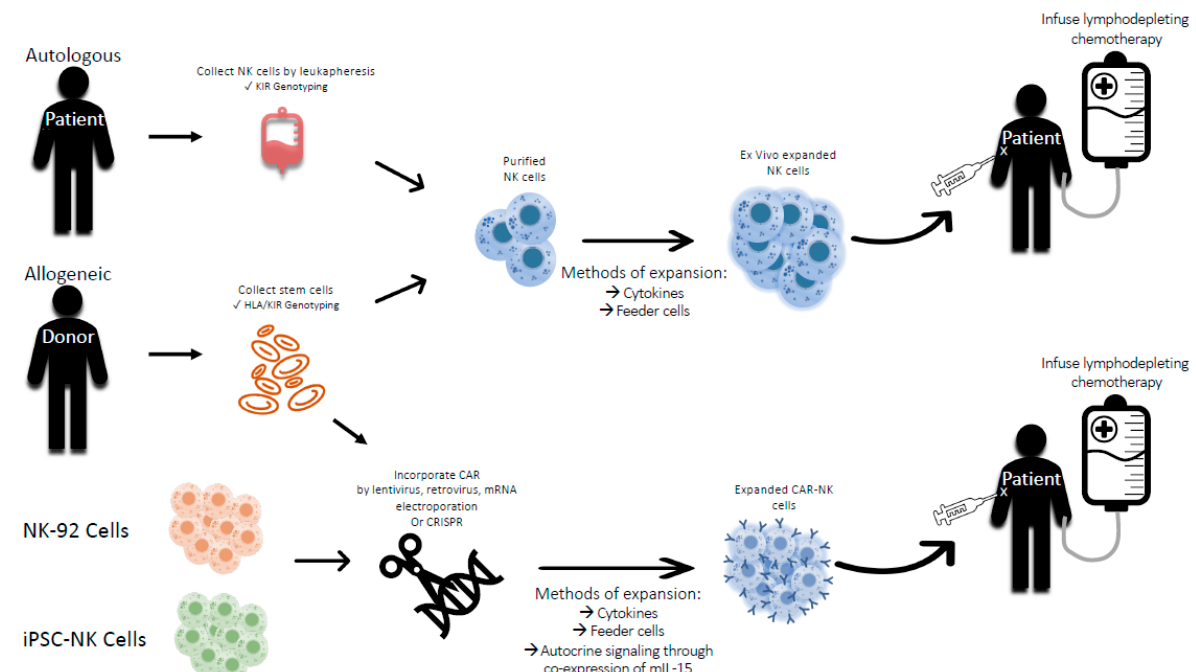
Figure 2. Approaches to clinical applications of adoptive NK cell therapy. Sources of NK cells may originate from an autologous donor or allogeneic donor, which will influence how they are collected. Peripheral blood mononuclear cells from autologous donors are collected using leukapheresis and may be subject to KIR genotyping, whereas peripheral blood mononuclear cells from allogeneic donors may be subject to HLA and KIR genotyping. Other allogeneic sources of NK cells include NK cells from cord blood, a cell line such as NK-92 cells, or NK cells derived from induced pluripotent stem cells (iPSC). These sources of NK cells offer the benefit of being an “off-the-shelf” adoptive cell therapy. NK cells require expansion and activation through cytokines, such as IL-2, IL-12, IL-15, IL-18, or IL-21. Membrane bound (mb) IL-15 or IL-21 with 41BB ligand have been genetically engineered into feeder cell lines, such as K562 cells, to generate robust NK expansions. NK cells can be genetically modified to express CARs that enable them to target a specific antigen. Recent developments in CAR NK technology have found that co-expression of IL-15 enhances CAR NK persistence, therefore